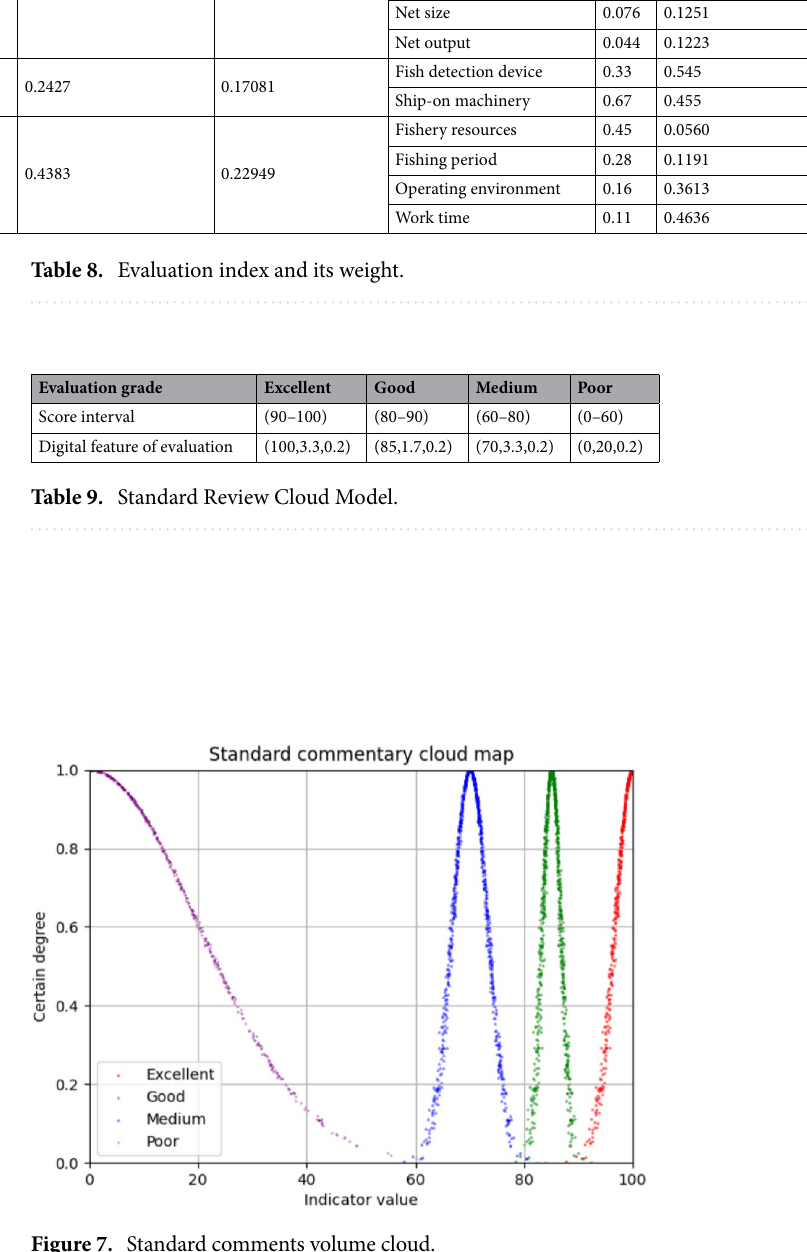
Figure 7. Standard comments volume